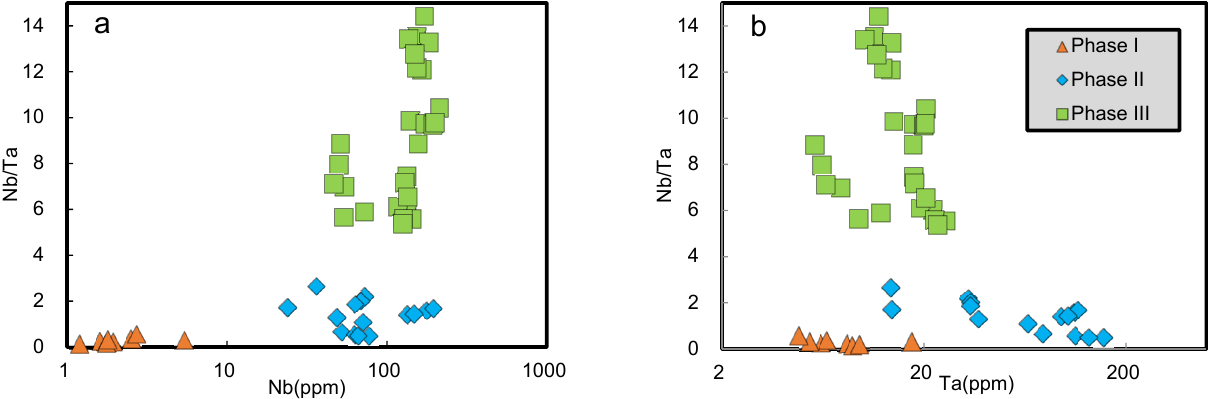
Figure 4. Nb/Ta ratio vs. Nb and Ta content of Phase Ι , ΙΙ and ΙΙΙ zircon. ( a ) Nb/Ta ratio vs. Nb content of Phase Ι , ΙΙ and ΙΙΙ ; ( b ) Nb/Ta ratio vs. Ta content of Phase Ι , ΙΙ and ΙΙΙ .